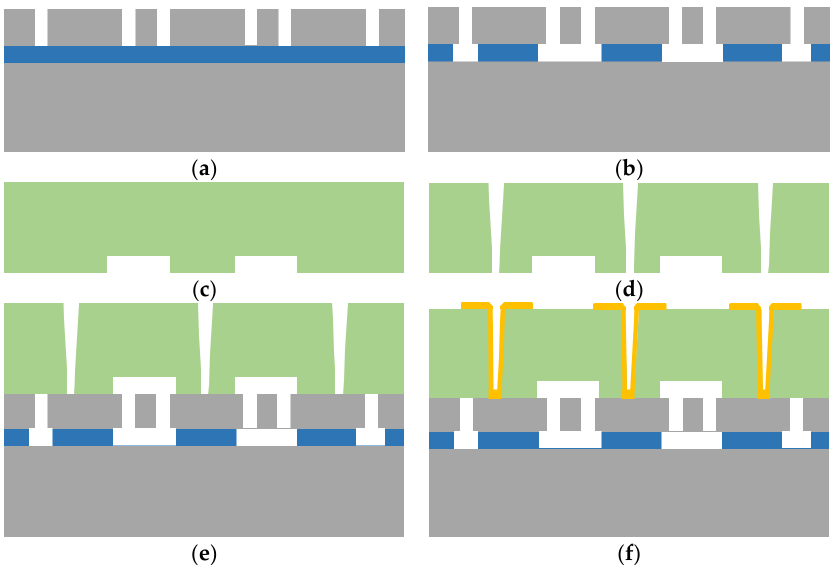
Figure 7. Fabrication process flow of a MEMS device with TGV: ( a ) Structure etch; ( b ) HF release; ( c ) space etch; ( d ) TGV drilling; ( e ) anodic bonding; and ( f ) patterned metal deposition.